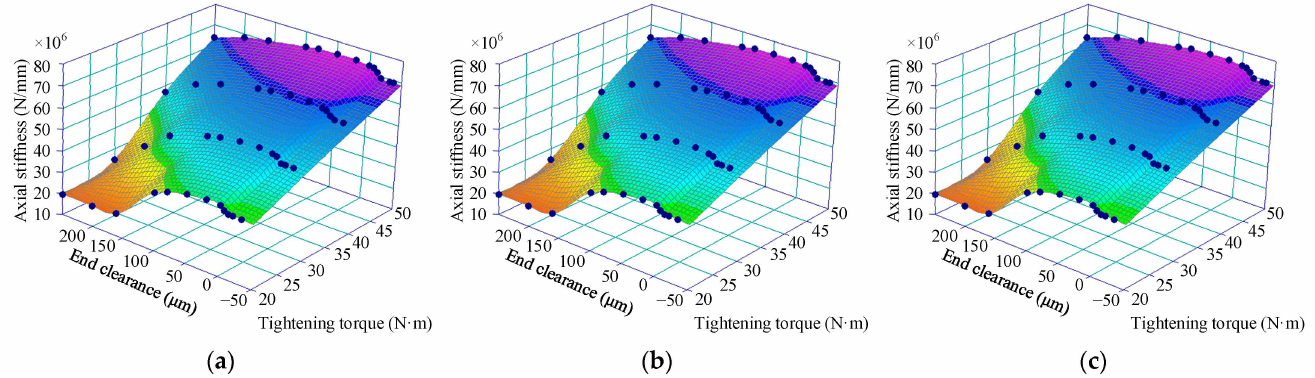
Figure 12. Effect of original end clearance on contact stiffness of the spindle–GWF interface under different tightening torques: ( a ) axial stiffness of the spindle–GWF interface; ( b ) radial stiffness of the spindle–GWF interface; ( c ) angular stiffness of the spindle–GWF